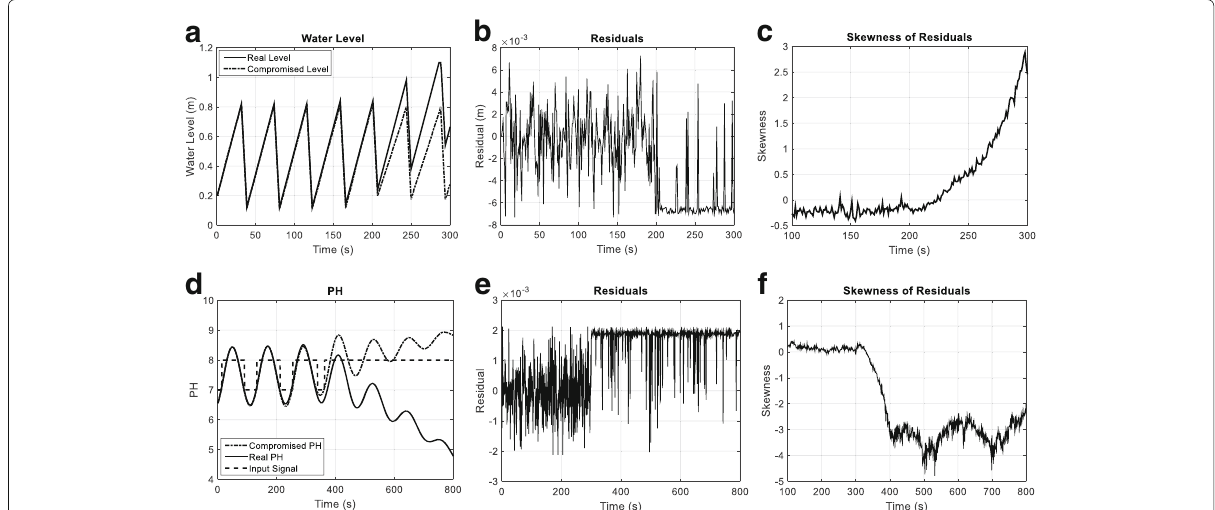
Fig. 9 Detection of stealthy attacks with a certain percentage of random residuals. When stealthy attacks with a certain percentage of random residuals in ( b ) and ( e ) are conducted on the water level control system and the pH value control system, respectively, the real water level shown in ( a ) deviates significantly from the seemingly normal but compromised water level, and the real pH value shown in ( d ) also deviates observably from the seemingly normal but compromised pH value. The significant changes of skewness coefficients of residuals shown in ( c ) and ( f ) indicate that the approach proposed can identity stealthy attacks with a certain percentage of random residuals